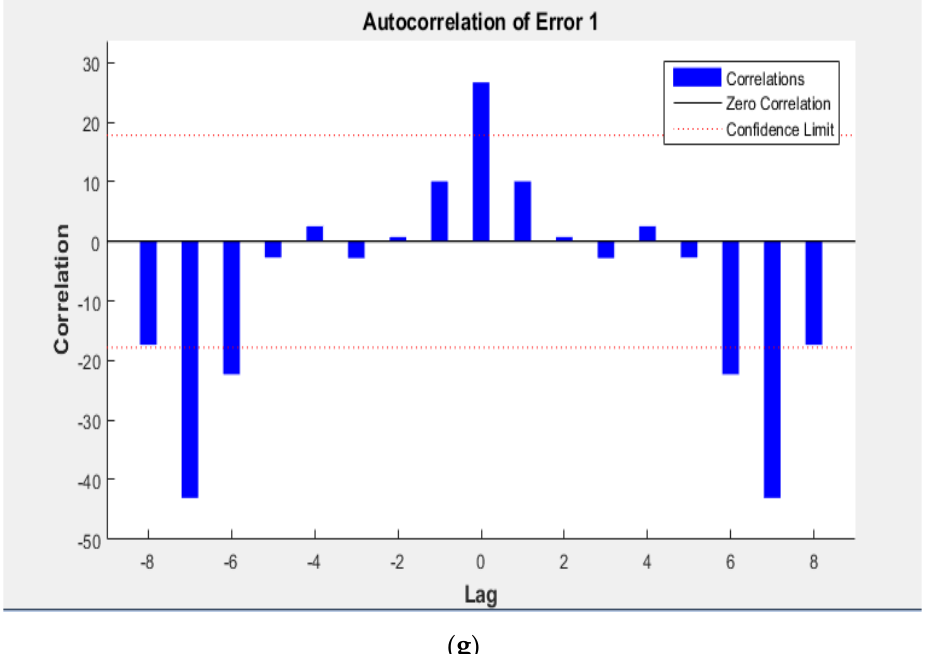
Figure 3. Levenberg – Marquardt back-propagation neural network (LMBNN) for urea adsorption. ( a ) Neural network overview; ( b ) training performance; ( c ) variation in gradient, training gain (mu) and validation fail for epoch range 0 to 5; ( d ) error histograms with 20 bins; ( e ) response of output element; ( f ) results of curve fitting with variation in target; ( g ) autocorrelation of error with variation of lag.